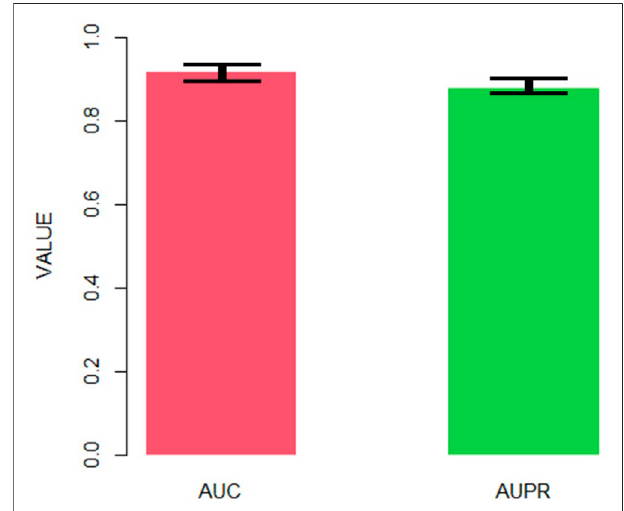
FIGURE 4 | The AUC and AUPR of AdaRVM in 10-cross